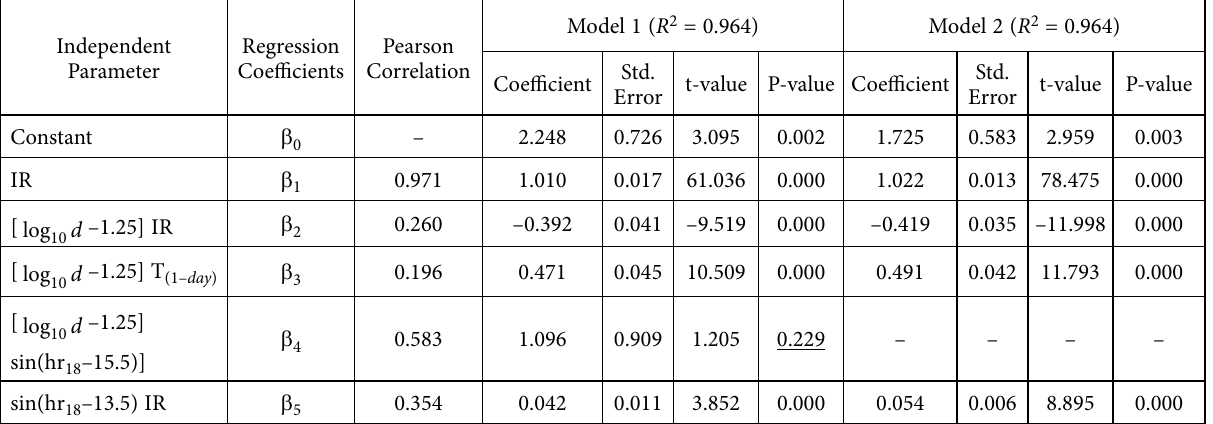
Table 4. Statistical parameters of new BELLS model for new pavements